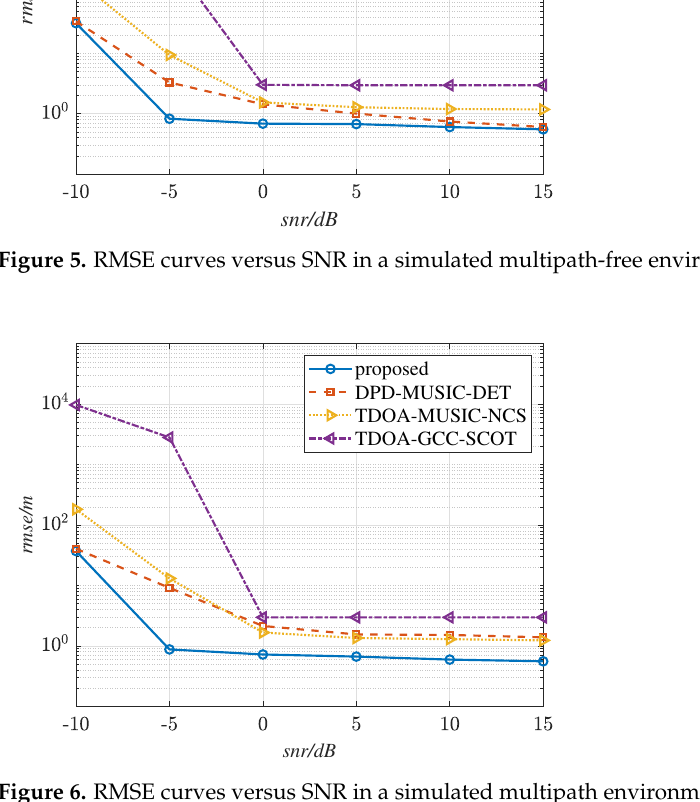
Figure 6. RMSE curves versus SNR in a simulated multipath environment ( M = 3 )